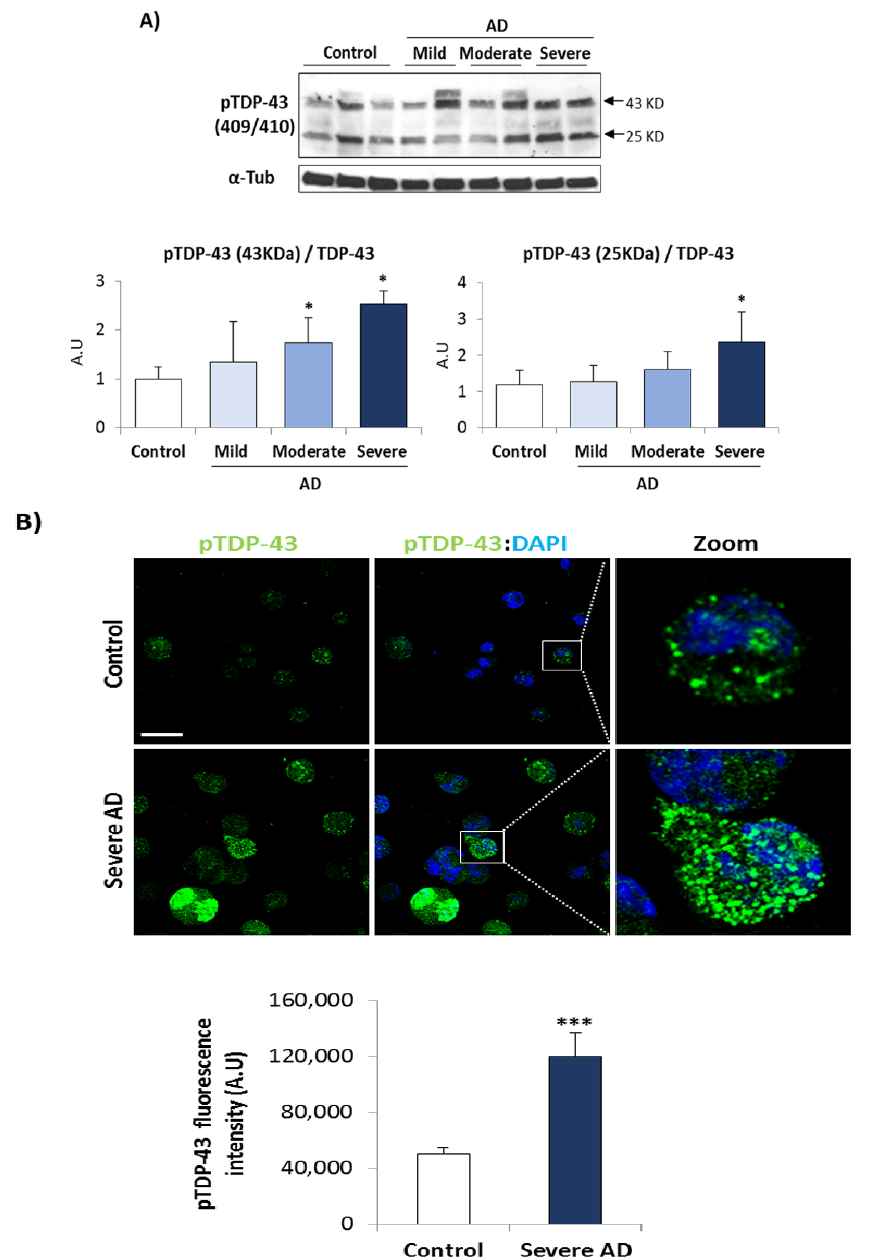
Figure 2. TDP-43 phosphorylation is increased in AD lymphoblasts. Immortalized lymphocytes from control and AD subjects (mild, moderate or severe patients) were incubated as described in legend of Figure 1, ( A ) Representative Western blot analysis of AD and control samples with pTDP- 43 (Ser409/410) antibody. α -tubulin was used as loading control. Densitometric quantification of pTDP43 was normalized with total TDP-43 levels. Bars are the mean ± SD for each experimental group of two independent experiments. Statistical analysis was performed using 1-way analysis of variance (ANOVA; pTDP-43 (43KDa): F 3.11 = 5.356, pTDP-43 (25KDa): F 3.10 = 3.842). (* p < 0.05). ( B ) Immunofluorescence staining of pTDP-43 (green) in control or severe AD lymphoblasts. Nuclei were counterstained with DAPI (blue). Scale bar, 20 µm. Fluorescence intensity quantification was performed using Image J software in at least 4 fields of view (A.U, arbitrary units). Bars are the mean ± SD of two independent experiments. Statistical analysis was performed using the Student t test (*** p <